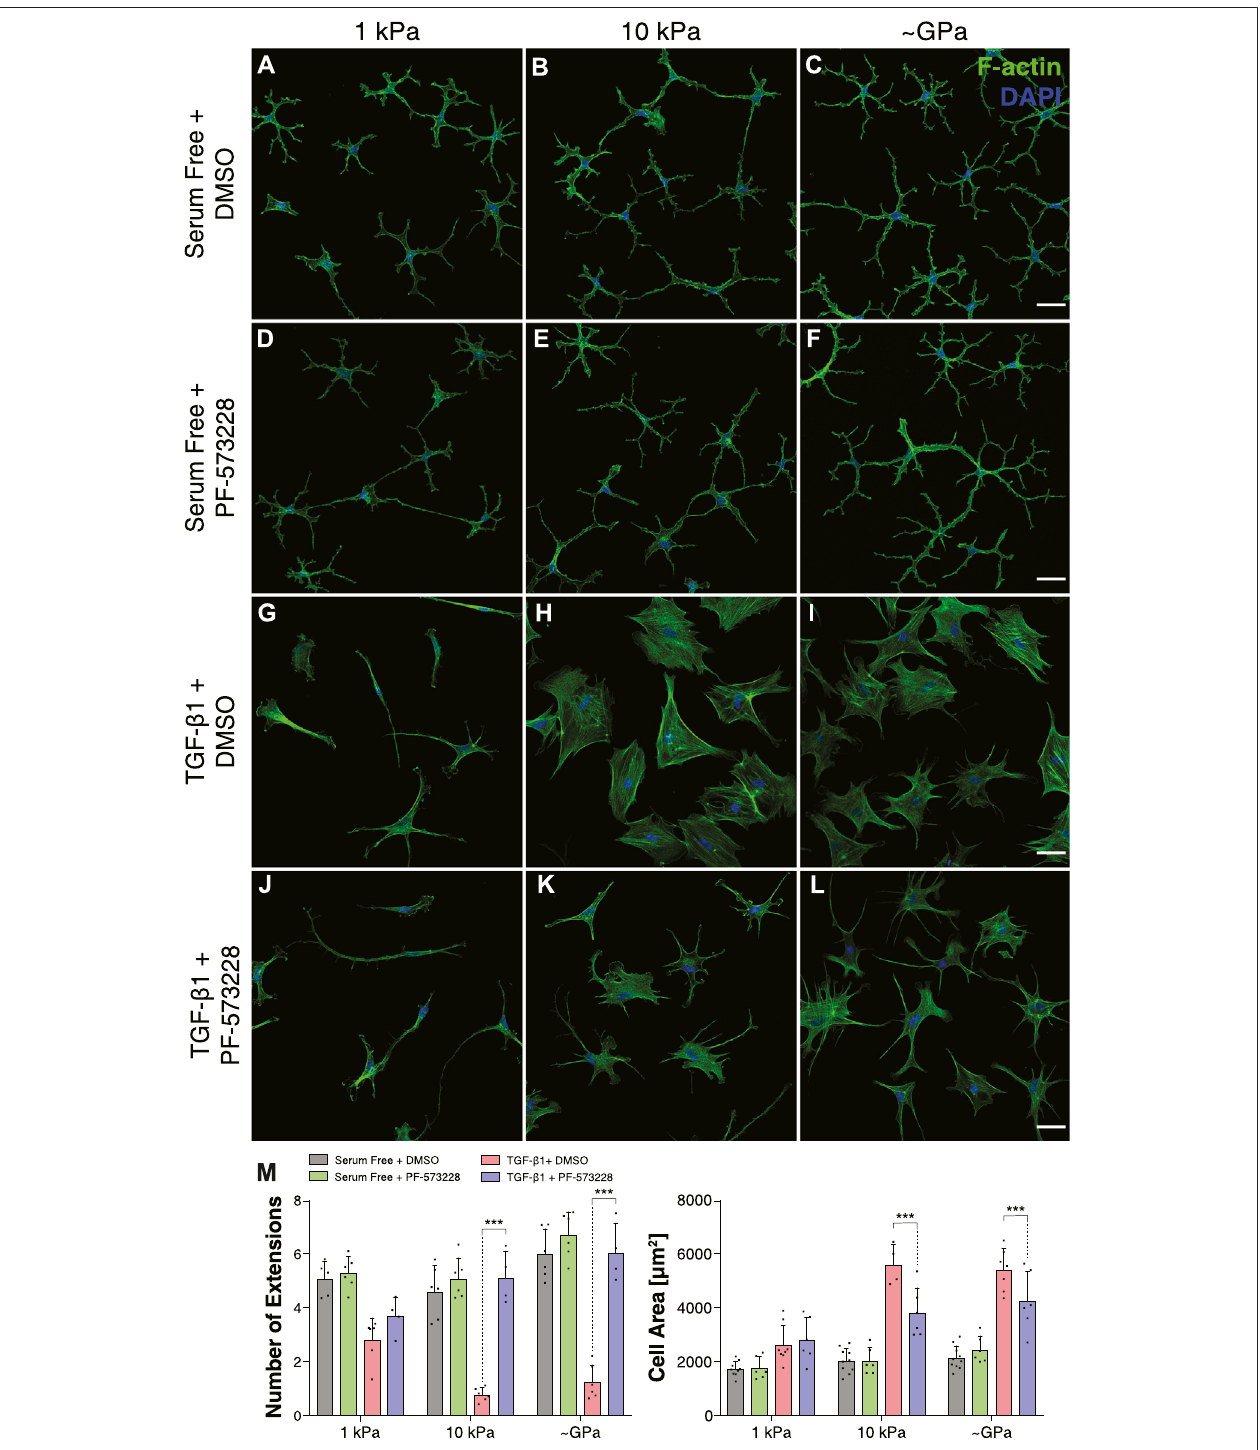
FIGURE 4 | Inhibition of FAK promotes dendritic cell morphologies on substrata of all stiffnesses in the presence of TGF- β 1. (A – L) Characteristic confocal fl uorescence images of cells cultured on either functionalized 1 kPa (A,D,G,J) or 10 kPa (B,E,H,K) PA substrata, or collagen-coated glass (C,F,I,L) coverslips. Cells were cultured for 5 days in either serum-free conditions (A – F) or in medium containing exogenous TGF- β 1 (G – L) , and in either the presence (D – F,J – L) or absence (A – C,G – I) of the FAK inhibitor, PF-573228. Cells were stained for both F-actin (green) and DAPI (blue). Scale bars, 50 μ m. (M) Quanti fi cation of cell morphologies. Error bars represent mean ± s.d. for n = 6 substrates from 3 experimental replicates. A two-way ANOVA followed by a Tukey post-hoc test was used to evaluate signi fi cance among groups. (***, p < 0.001).